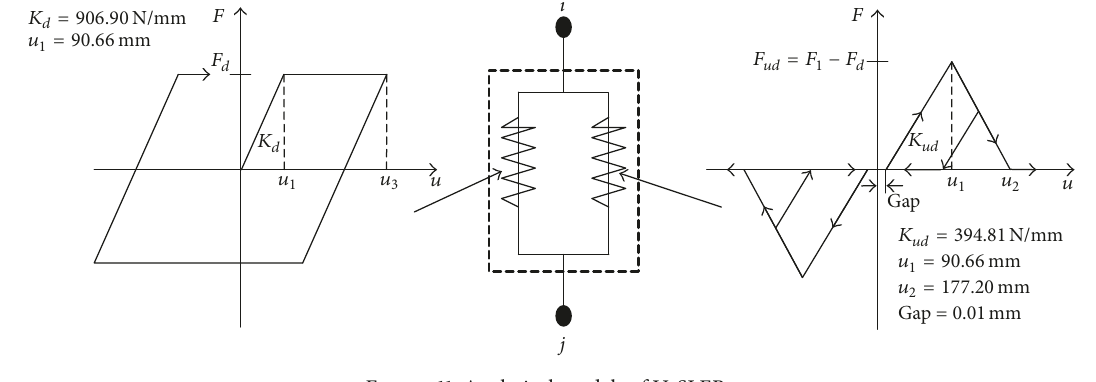
Figure 11: Analytical models of U-SLEBs. Table 4: Comparison of both the equivalent stiffness and damping ratio of specimen Y2-8/45-UB.